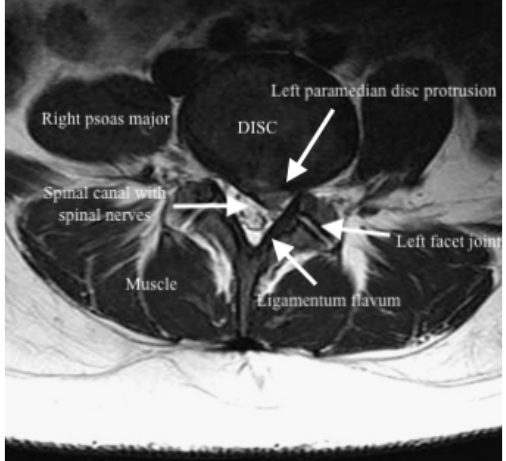
Fig 2. MRI T2 axial showing a left paramedian disc protrusion at L4-5 IVD level causing narrowing of left neural